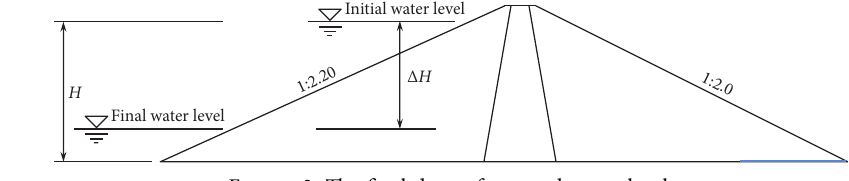
Figure 2: The final drop of external water level.